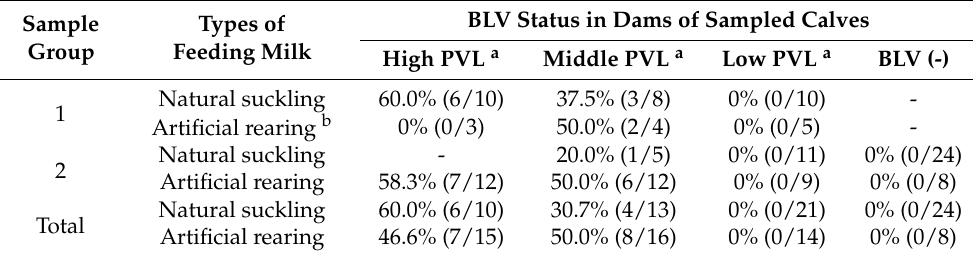
Table 2. BLV positivity in 1-month-old calves fed with udder milk, pasteurized colostrum and colostrum